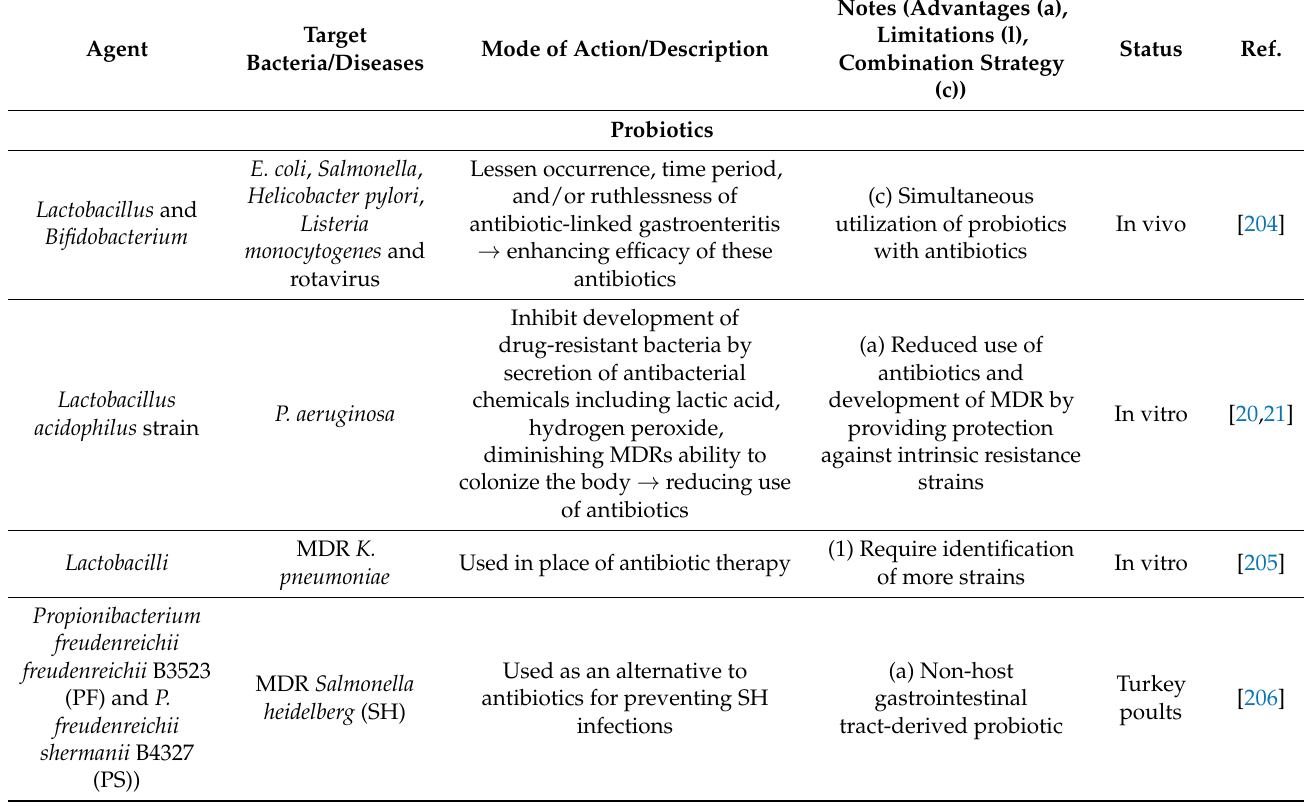
Table 8. Different types of probiotics used to combat